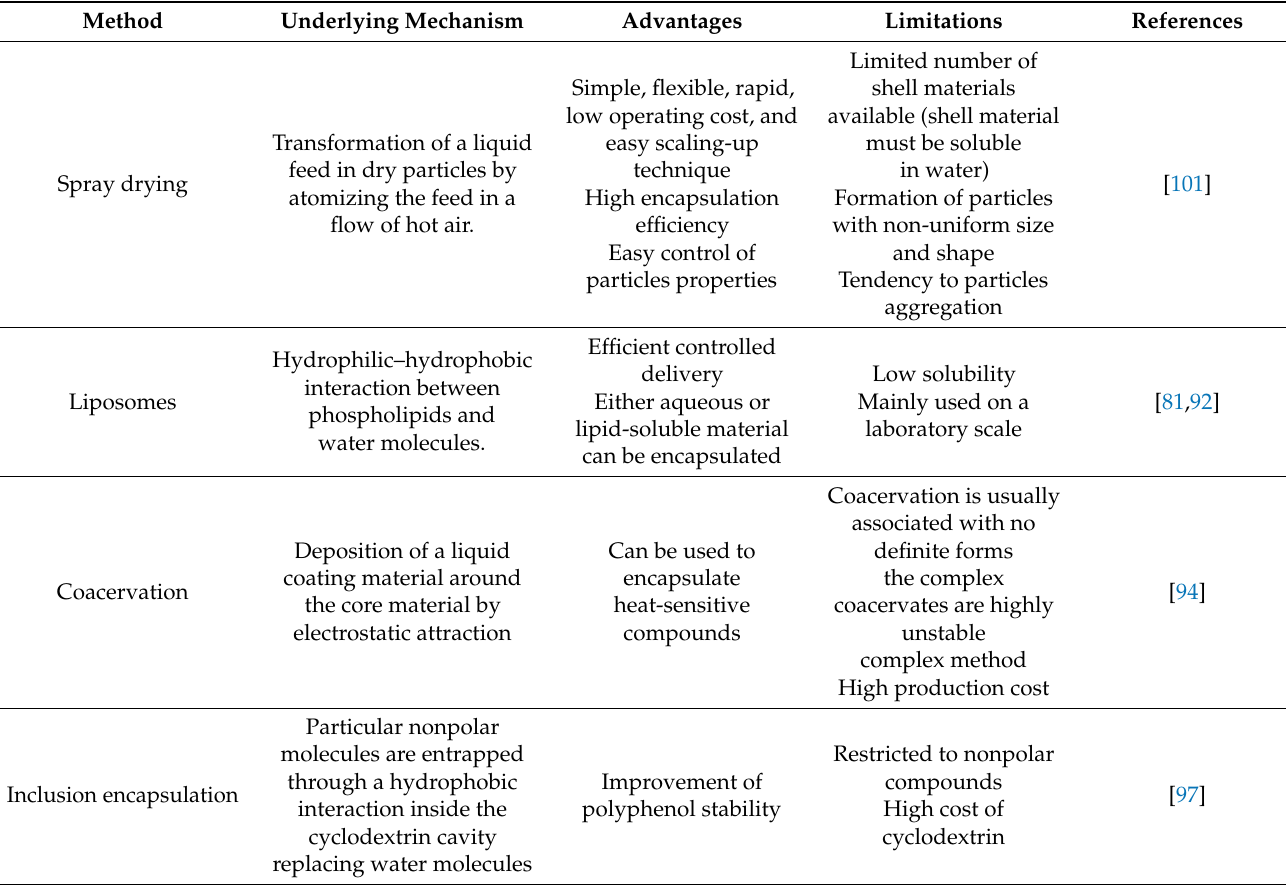
Table 2. Advantages and limitations of some encapsulation methods applicable for